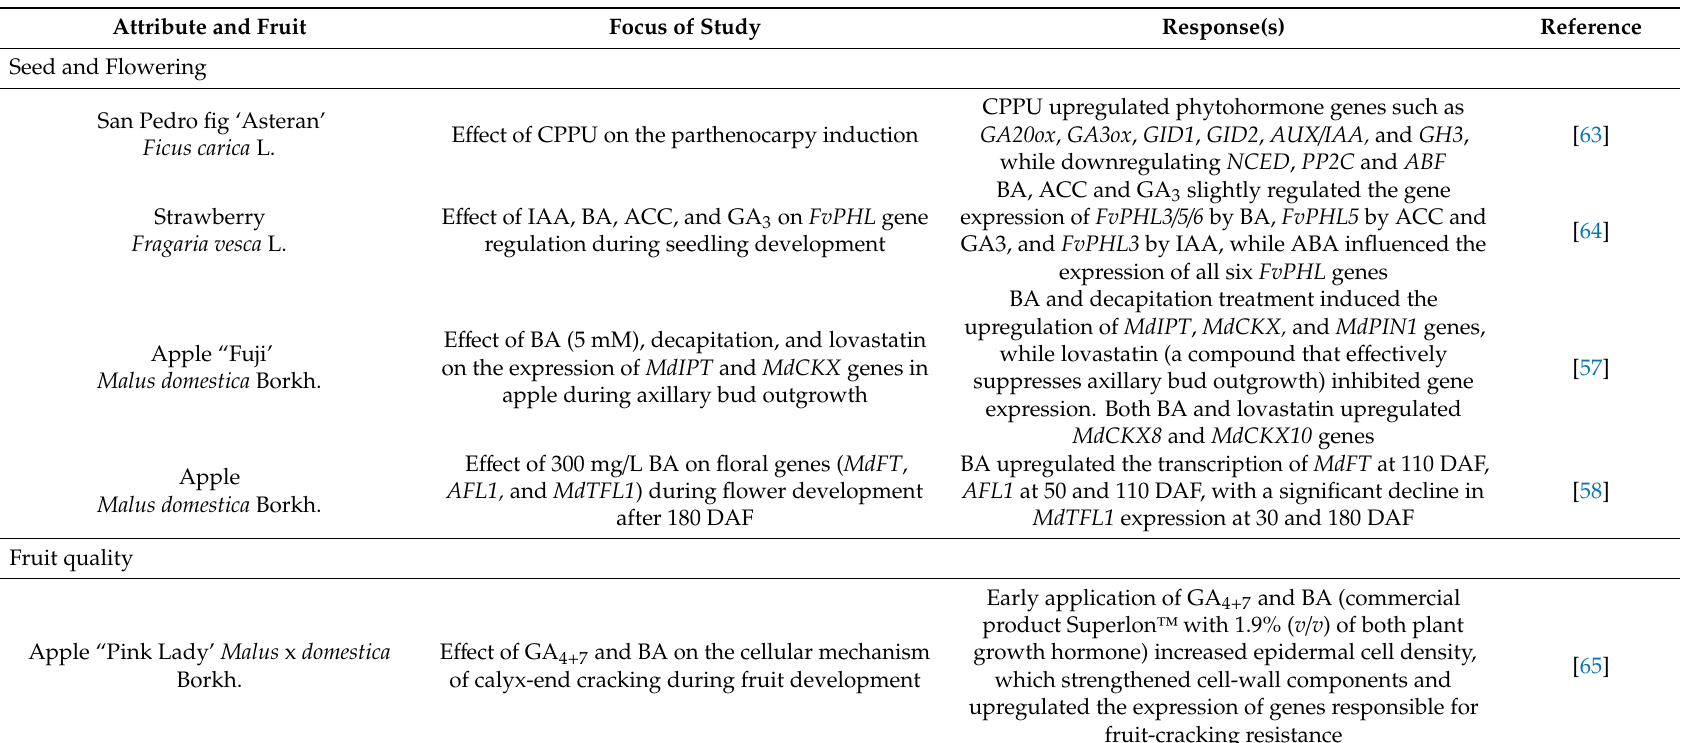
Table 1. Gene expression-related responses to cytokinin application in di ff erent horticultural fruit